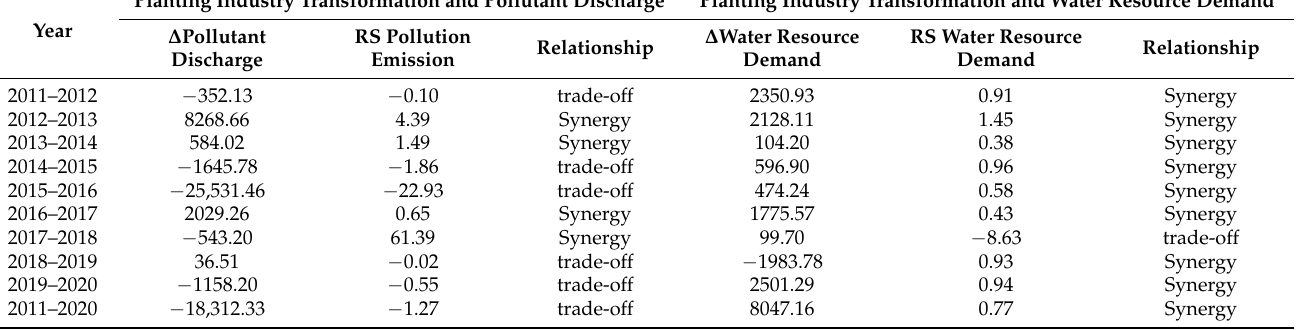
Table 4. Coupling characteristics of planting industry transformation with resource and environment pressures in Ganzhou district from 2011 to 2020.